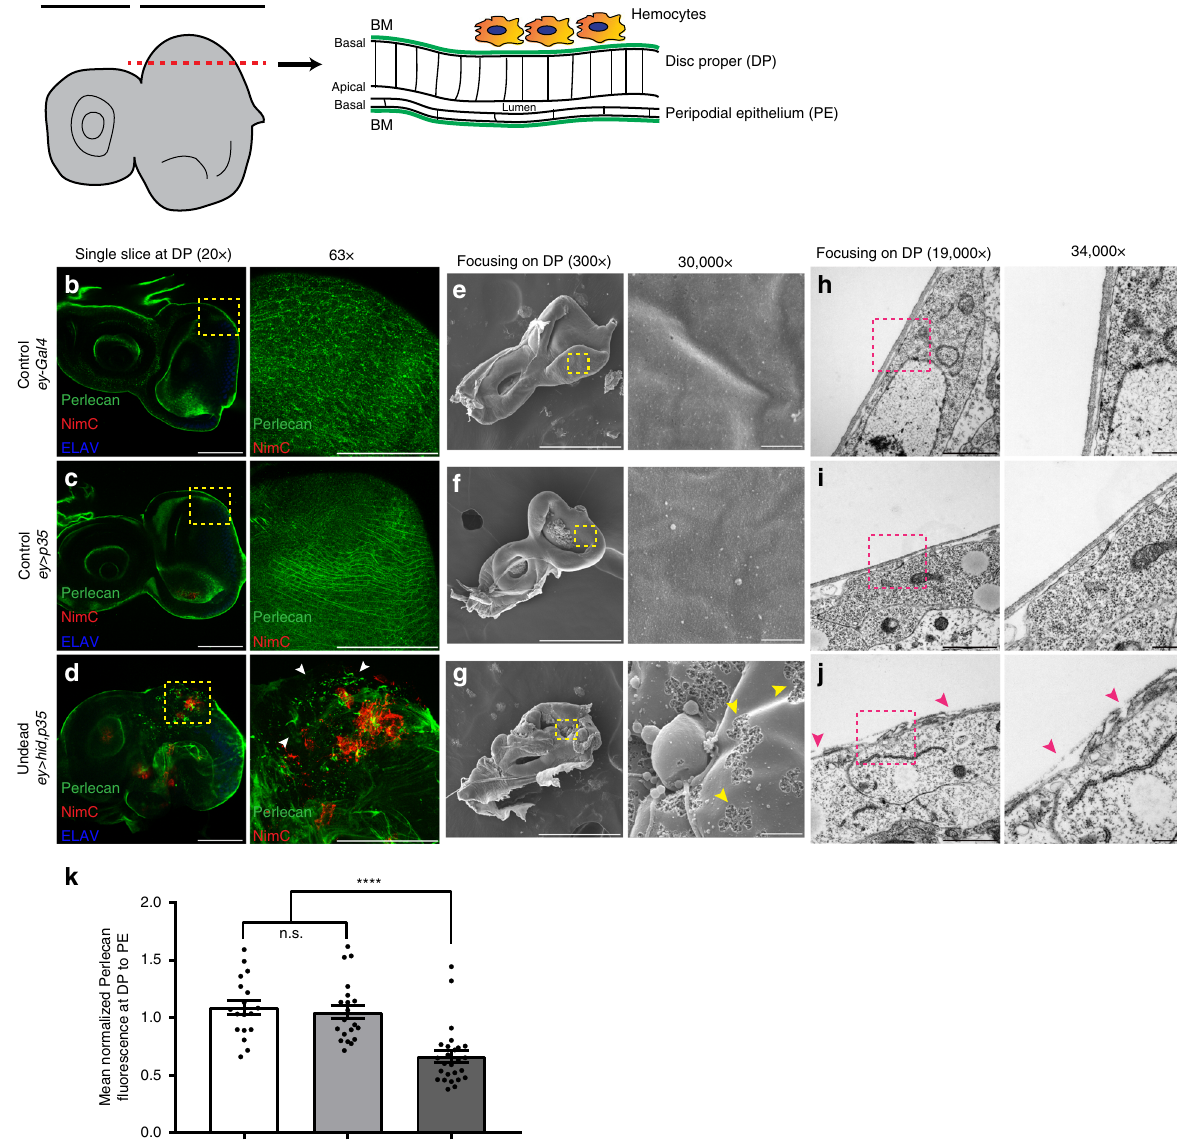
Fig. 1 Undead discs have damaged basement membranes (BM). a Schematic representation of a surface view (XY; left) and an orthogonal section view (XZ; right) along the red dotted line through a 3rd instar larval eye-antennal imaginal disc. The columnar disc proper (DP) and squamous peripodial epithelium (PE) are apically separated by a lumen, their basal surfaces surrounded by the basement membrane (BM, green). Hemocytes attach speci fi cally at the basal side of the DP. b – d Representative examples of control ( ey-Gal4 ( b ) and ey > p35 ( c )) and experimental (undead) ( ey > hid,p35 ( d )) eye discs labeled for the BM marker Perlecan (green), for hemocytes with NimrodC (NimC) (red) and ELAV (blue) marking posterior photoreceptor neurons. Single slices focusing on the basal side of the DP (left), yellow squares are magni fi ed (right). Damaged BM surrounded by hemocytes (red) indicated by white arrowheads ( d , right). Scale bars, 100 μ m. e – g Scanning electron microscopy (SEM) images of ey-Gal4 ( e ), ey > p35 ( f ), and ey > hid,p35 ( g ) discs focusing on the DP side, yellow squares magni fi ed (right). Damaged surface of BM indicated by yellow arrowheads ( g , right). Scale bars, 200 μ m (left) and 1 μ m (right). h – j Transmission electron microscopy (TEM) images of ey-Gal4 ( h ), ey > p35 ( i ), and ey > hid,p35 ( j ) discs focusing on the DP side, magenta squares magni fi ed (right). Discontinuous BM indicated by magenta arrowheads ( j , right). Scale bars, 0.5 μ m (left) and 0.2 μ m (right). k Quanti fi cation of Perlecan labeling at DP normalized to PE as internal control reveals that the BM is damaged in undead ey > hid,p35 discs compared with controls. Quanti fi cation of Perlecan fl uorescence is taken from single slices at the basal surface of DP and PE. Data represented as mean fl uorescence ± SEM analyzed by one-way ANOVA with Holm – Sidak test for multiple comparisons. **** p < 0.0001, n.s. = no statistical signi fi cance. Data from n = 18 ( ey-Gal4 ), 20 ( ey > p35 ), and 26 ( ey > hid,p35 ) discs analyzed from fi ve independent experiments. Source data are provided as a Source Data fi in these experiments does not appear to be as smooth as in Next, we examined whether BM damage is triggered simply by controls, it is intact without any gaps, and the Perlecan intensity activation of apoptosis. Because expression of hid without p35 using ey-Gal4 causes early larval lethality, we expressed hid using is comparable to control discs (Supplementary Fig. 4a – b,d). spalt-Gal4 ( sal EPv > hid ) in wing imaginal discs. Although the BM